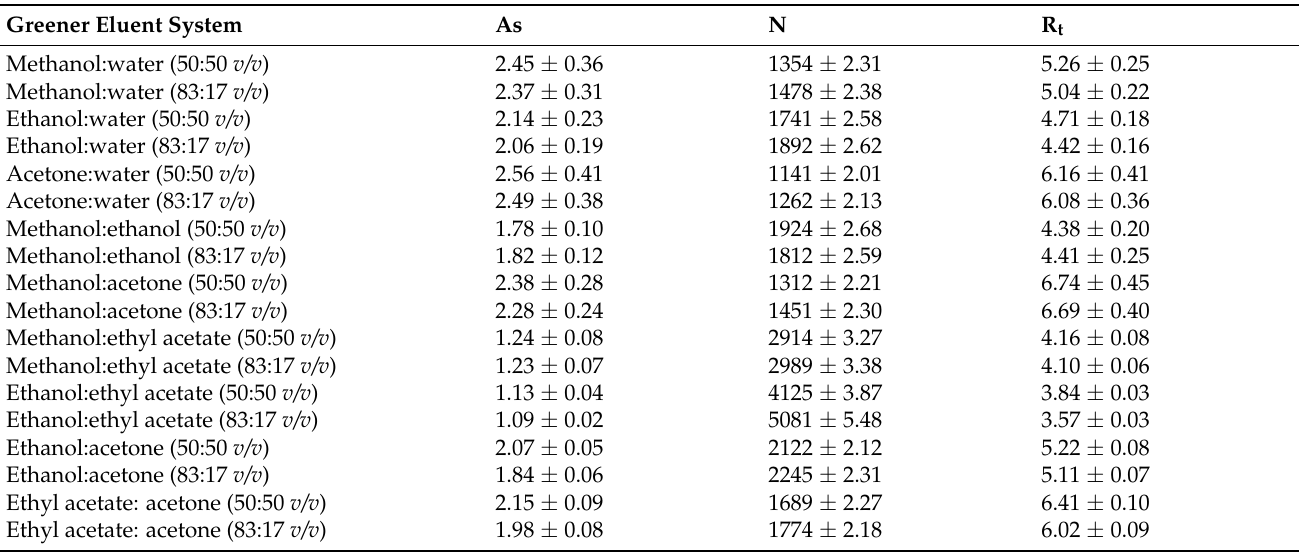
Table 1. The optimization of greener eluent systems and measured analytical responses for standard curcumin (CCM) (mean ± SD, n = 3).